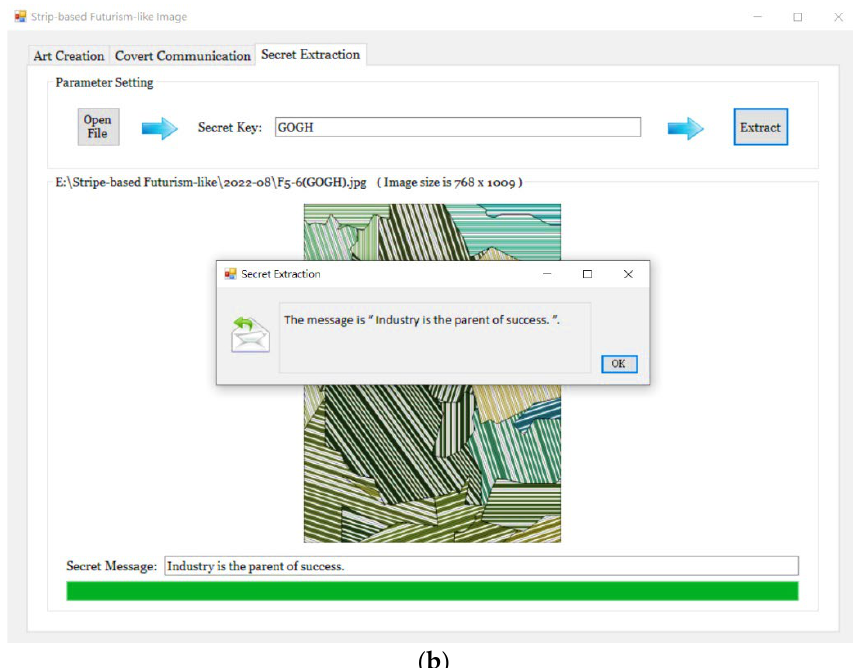
Figure 17. An illustration of extracting the secret message from the stego-image using the right secret key. ( a ) The stego-image with the stripe widths of 6 pixels shown in Figure 14e. ( b ) The correct result “Industry is the parent of success.” of hidden data extraction using the secret key “GOGH”.